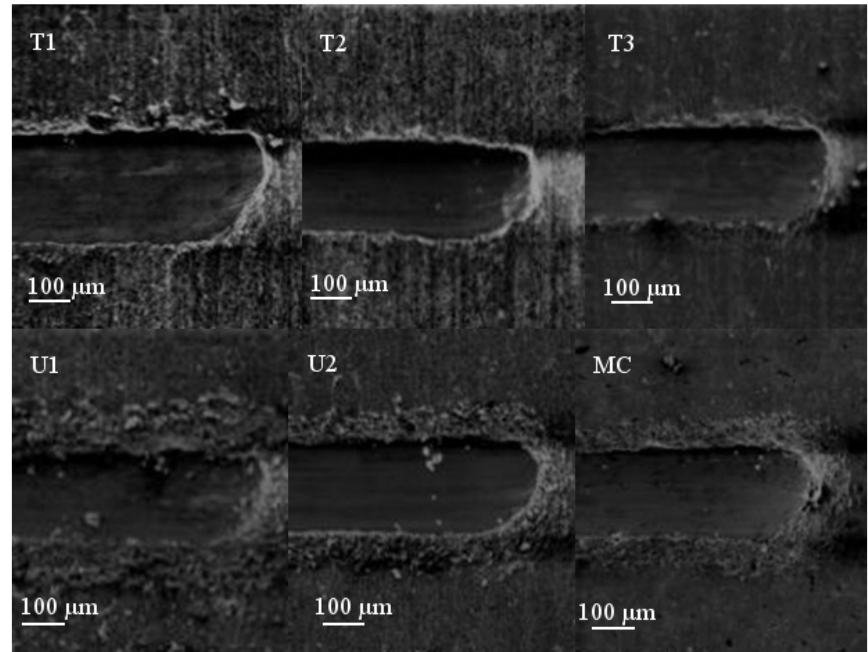
Figure 7. SEM micrographs showing the scratch tracks of coatings before and after process tests at Brewery